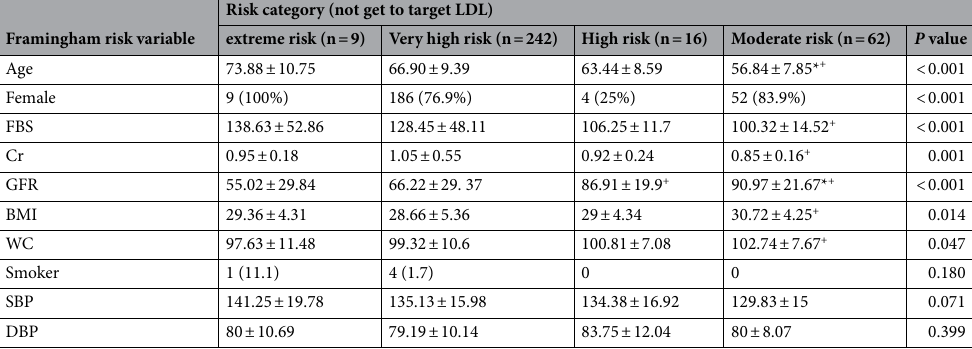
Table 4. Demographic characteristics of 329 patients who treated with statin derivations who did not get to target LDL. *Exterme risk versus other groups. + Very high versus other groups. # High versus other groups.